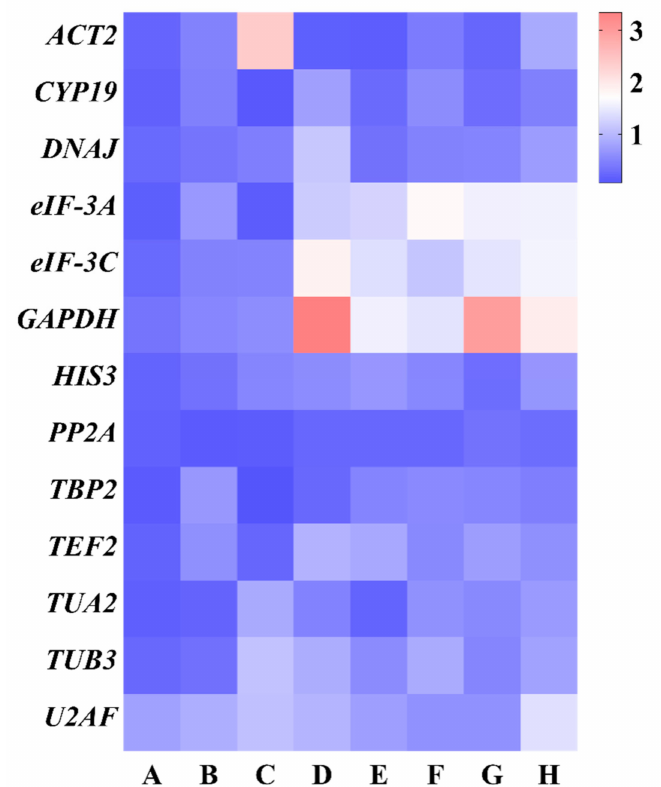
Figure 5. Expression stability of E. sibiricus potential reference genes calculated using NormFinder. ( A ) Di ff erent genotypes, ( B ) di ff erent developmental stages, ( C ) di ff erent tissues, ( D ) salt stress, ( E ) heat stress, ( F ) cold stress, ( G ) osmotic stress, and ( H ) all samples. Low to high expression stability is represented over a spectrum from red to blue,